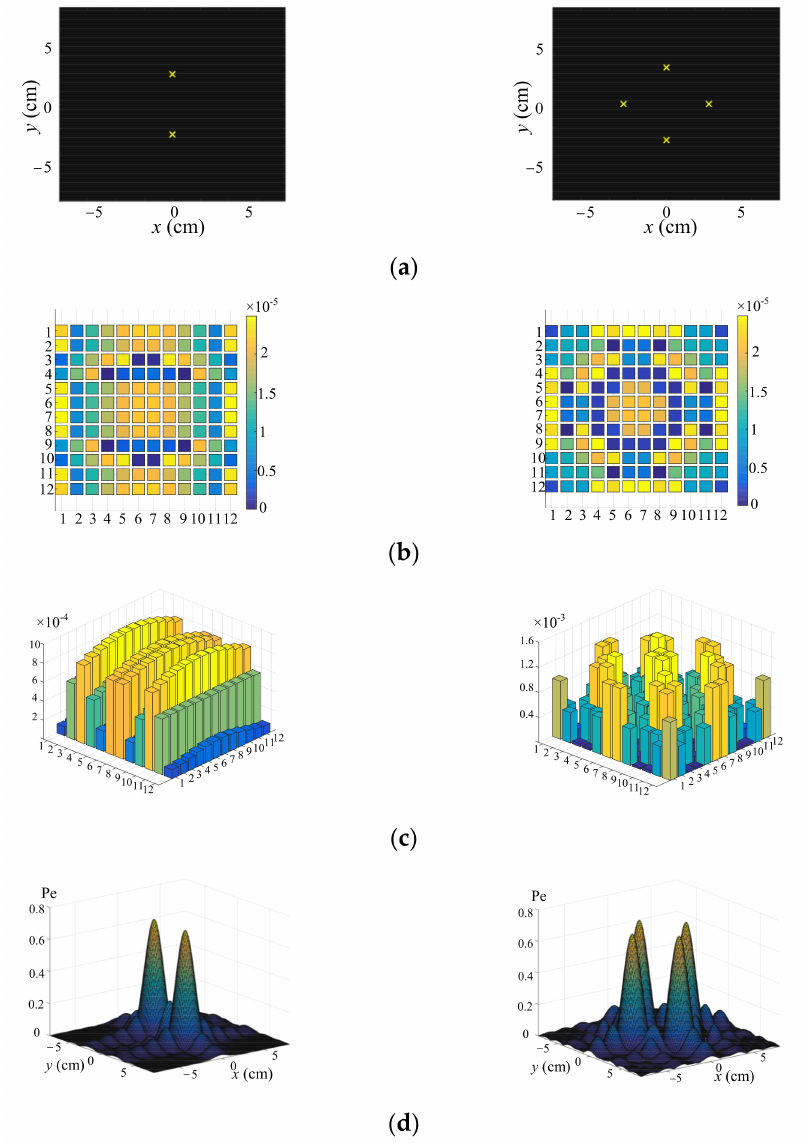
Figure 3. Simulation of multipoint focusing. ( a – d ) show the desired points, phase difference distribu- tion, amplitude distribution and the RMS values of the ultrasound pressure,